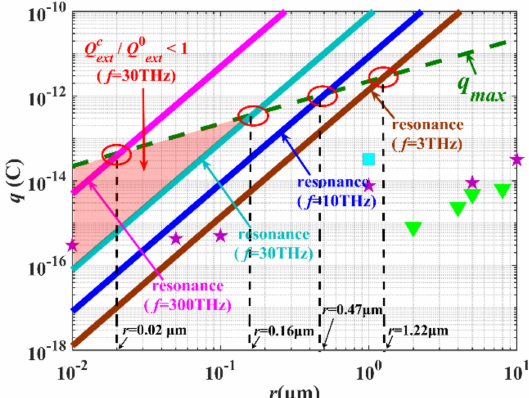
Figure 7. The shifts of the extinction amplification resonance and extinction reduction on the r – q parameter plane, as the frequency varies from 3 THz to 300 THz. Here, r denotes the radius of particle and q the particle’s total net charge. The thick solid lines (labelled with “resonance”) represent the positions of extinction amplification resonance. The shaded triangle region indicates positions, where the extinction reduction ( Q c / Q 0 < 1) occurs for f = 30 THz. The dashed line denotes the saturation ext ext charge q max ( r ) of a particle of radius r